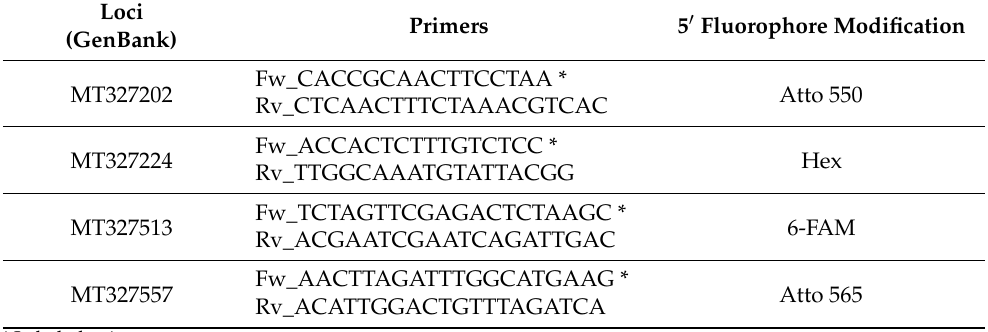
Table 1. SSR markers used for molecular identification of A. unedo clones.